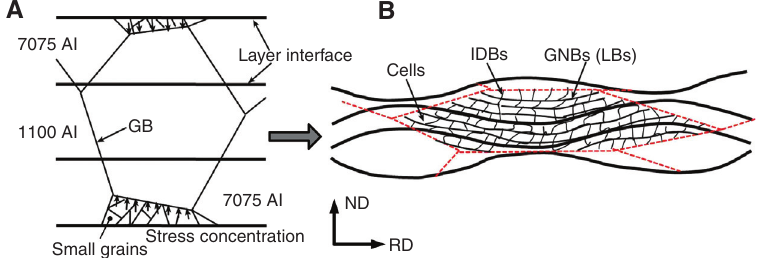
Figure 4 Schematic diagram showing grain refinement during cold rolling. (A) Grain distribution of multilayer composite sheet; (B) grain refinement